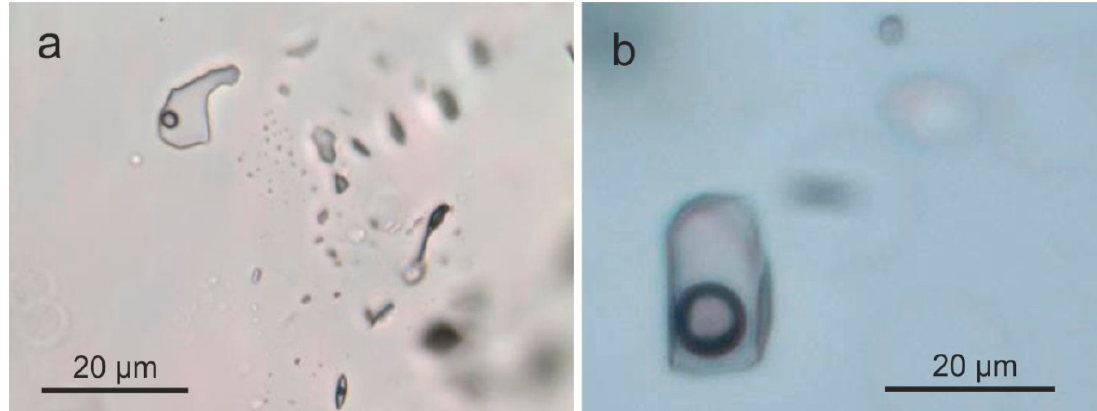
Figure 20. Primary two ‐ phase (gas ‐ liquid) inclusions in macrocrystalline quartz of agates from Saxony (Germany): ( a ) Burgstall, ( b ) St. Egidien.